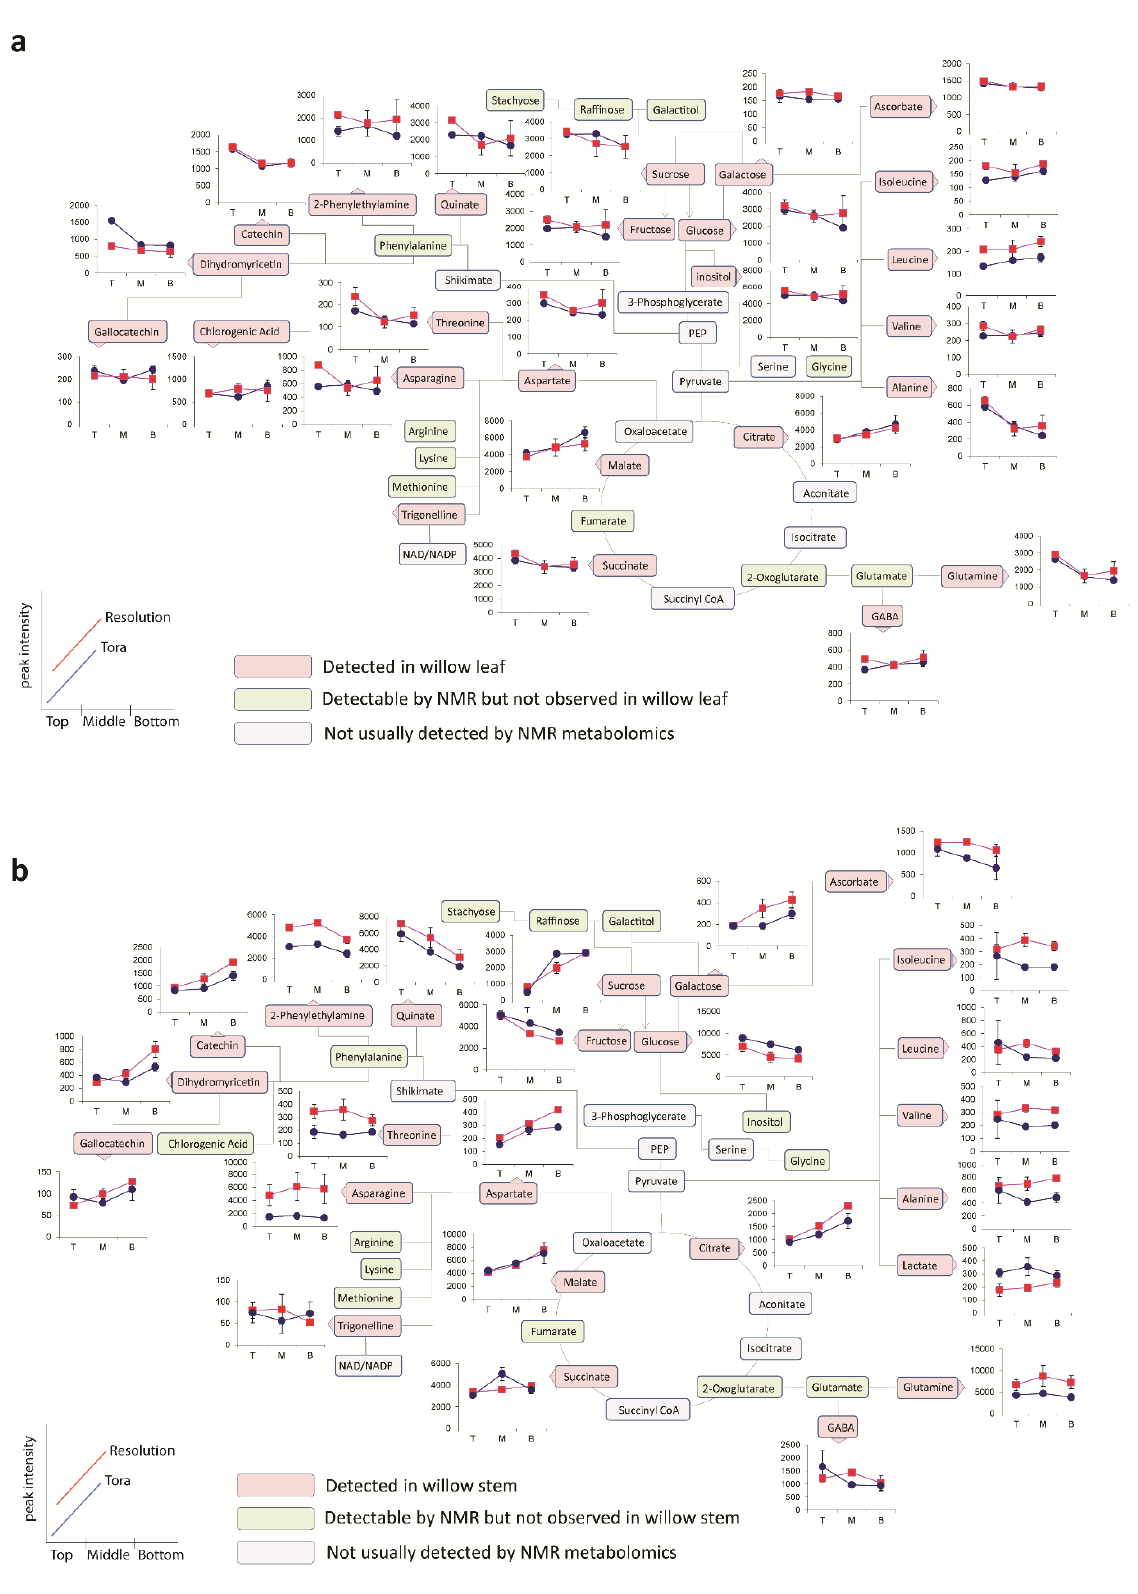
Figure 7. Trajectories for ( a ) leaf and ( b ) stem samples representing changes within the extractable metabolite pool. Data generated from 1D 1 H-NMR data using binned regions of characteristic peaks for each metabolite which were normalized back to a comparable 3 mg extractable pool weight. Plot intensities represent the intensity value of the normalized binned